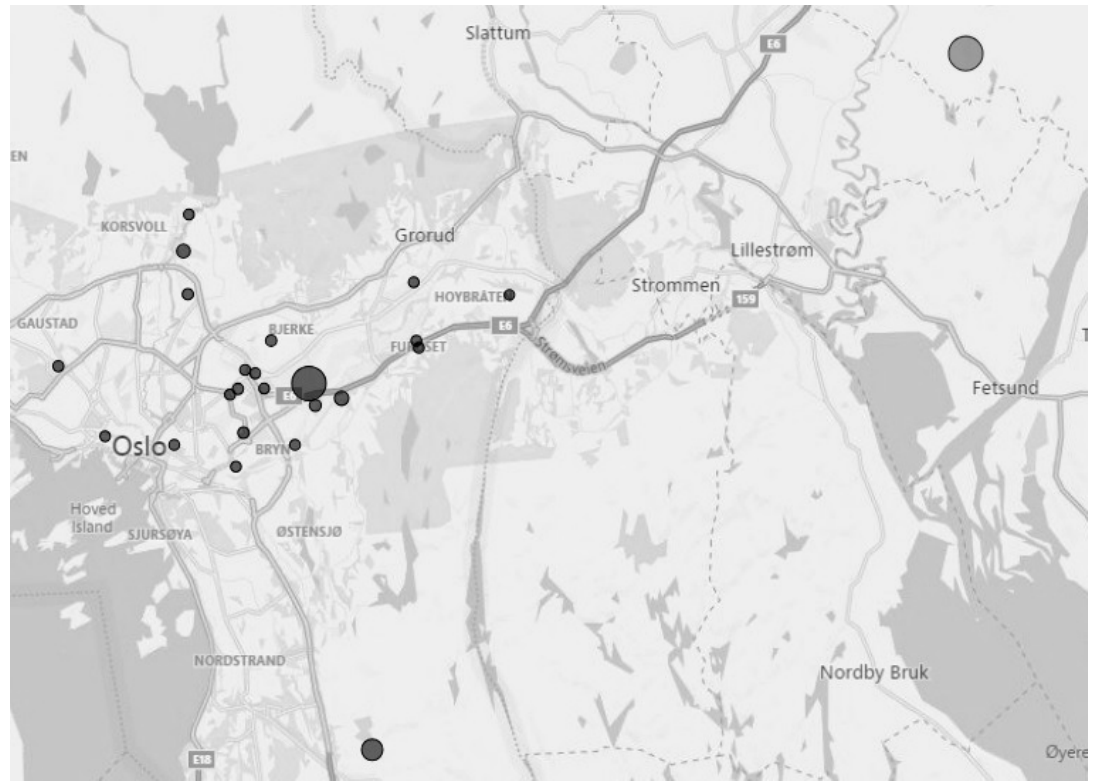
Figure 1. Location of collection and delivery points across the Oslo region. The delivery point is the separate location to the north-east. The points scale with the mass of waste collected/delivered.